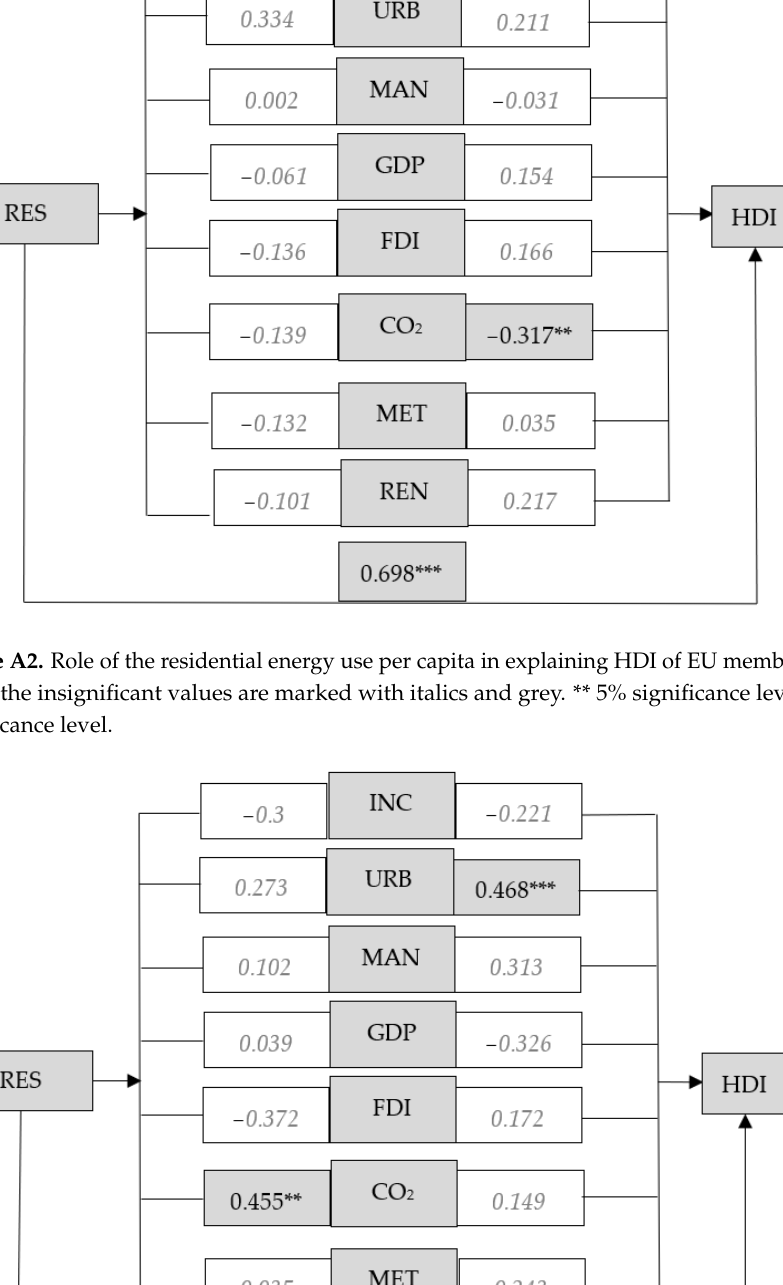
Figure A1. Role of the residential energy use per capita in explaining HDI of EU member states, 2000. Note: the insignificant values are marked with italics and grey. ** 5% significance level, and *** 1% significance level.